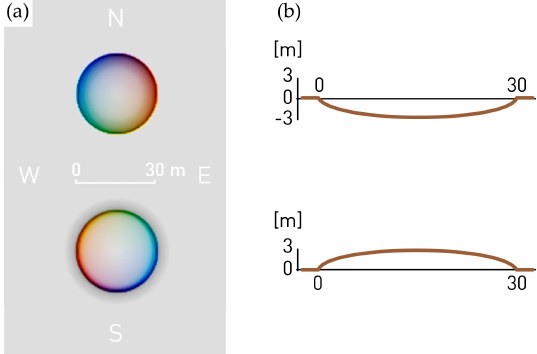
Figure 10. Different opacity settings and blend modes enable better representation of underlying colors. A combination of visualizations based on sky-view factor (25% opacity, multiply), positive openness (50% opacity, overlay), slope (50% opacity, luminosity), and an RGB composite image of hillshading from three directions. It is possible to see orientation of slopes from this image as demonstrated from the effect of the combination on a round, sharp-edged, shallow depression (top) and protrusion (bottom). The same combination is shown on Figure 9d.